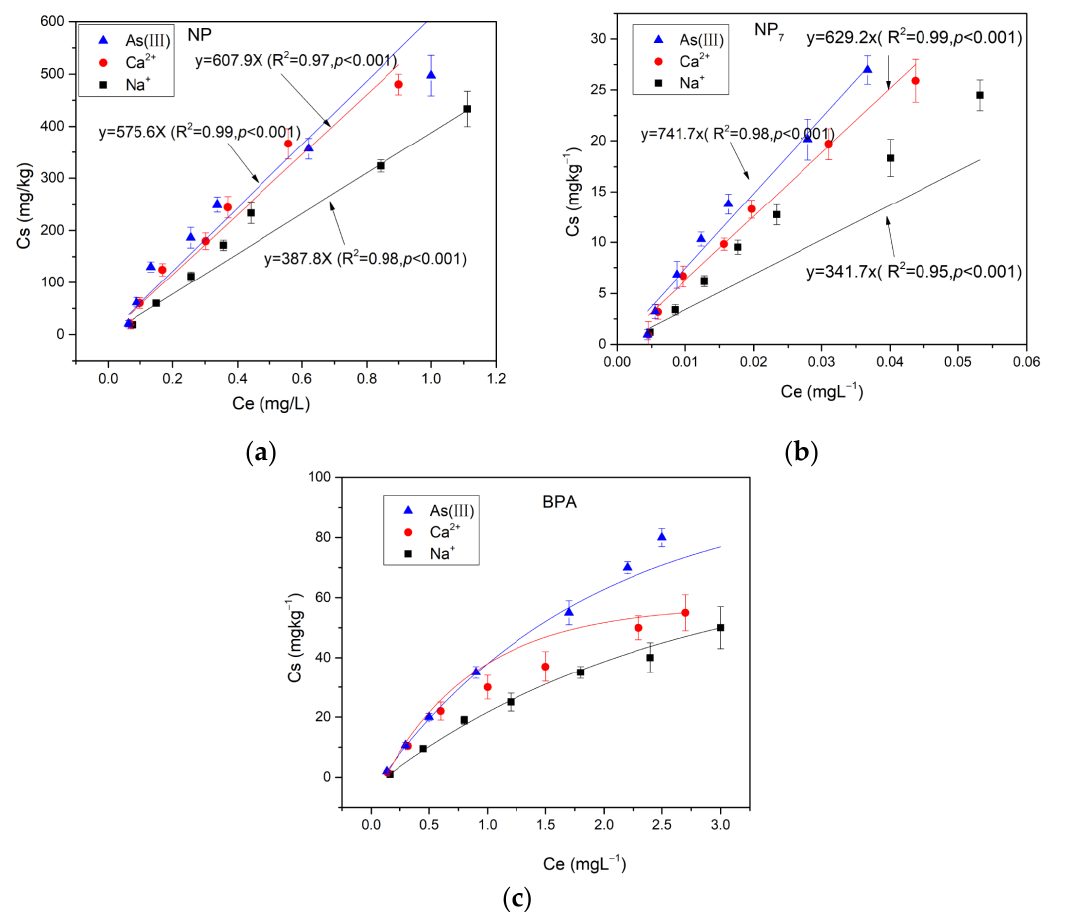
Figure 5. Adsorption of ( a ) NP, ( b ) NP 7 and ( c ) BPA on soil saturated with different polyvalent metal ions. Table 6. Freundlich model for BPA on soil at different polyvalent metal ions conditions.